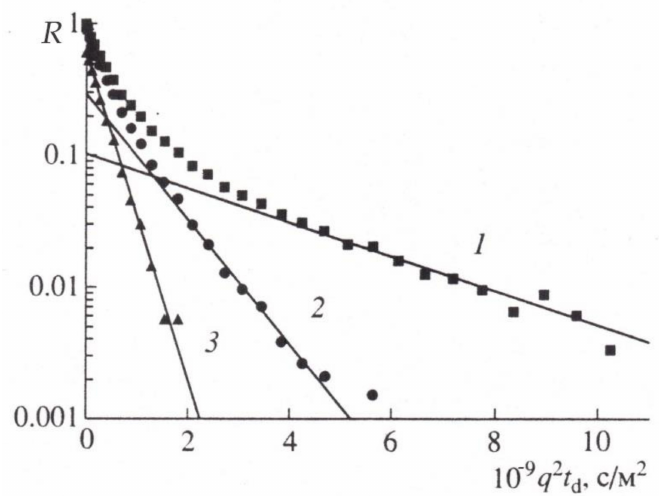
Figure 11. Diffusion decay of echo in wheat roots in the normal conditions (decomposition into three exponents, ( q 2 t d = γ 2 δ 2 g 2 t d , t d = 100 mc)